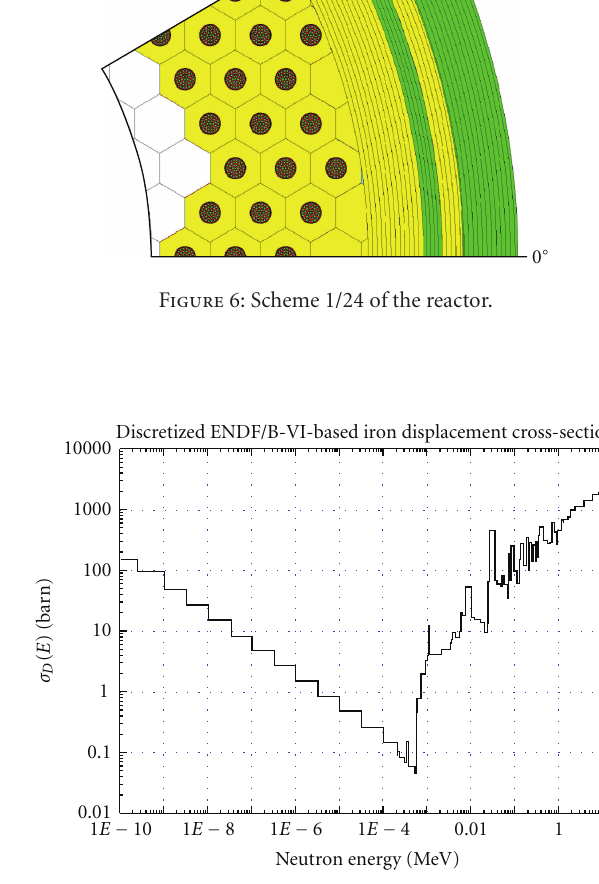
Figure 7: Discretized displacement cross-section for stainless steel based on a Lindhard model and ENDF/B scattering